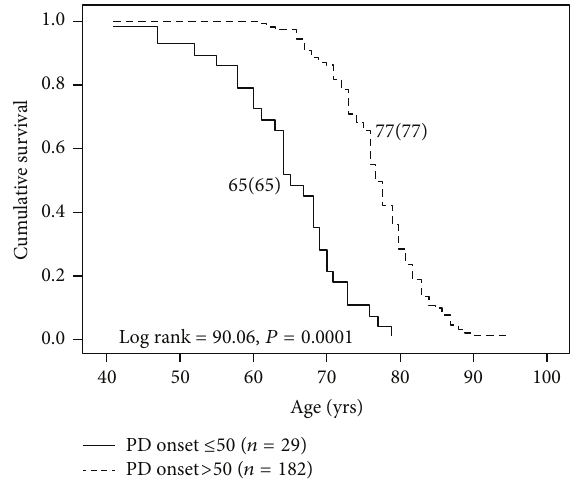
Figure 4: Survival analysis of PD patients with early age of onset (at age 50 or earlier) and later ages of onset. PD patients with early age of onset had markedly reduced survival (12 years) relative to the patients with later ages of